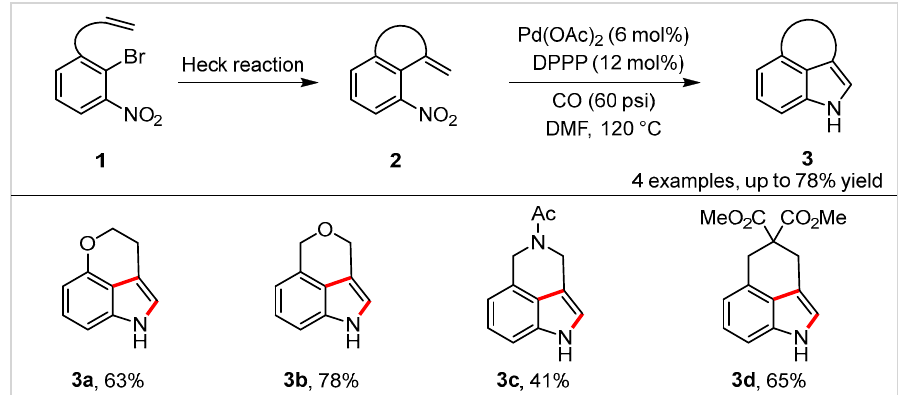
Scheme 2. Synthesis of 3,4-fused tricyclic indoles via two consecutive palladium-catalyzed reac-